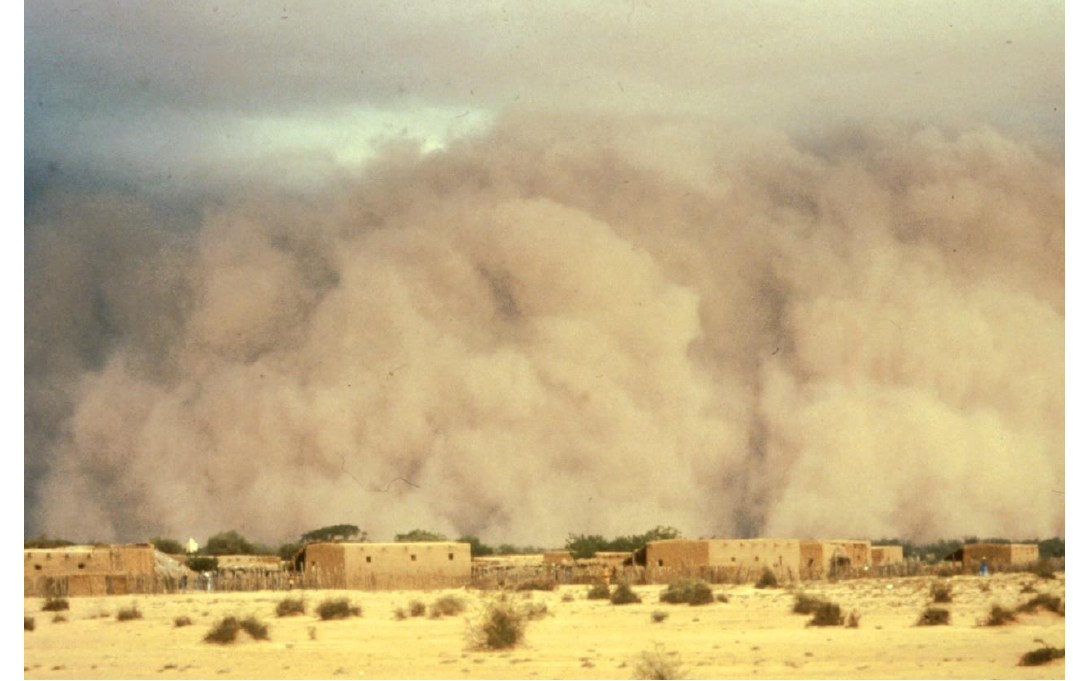
Figure 3. A dust storm near a village in Senegal.